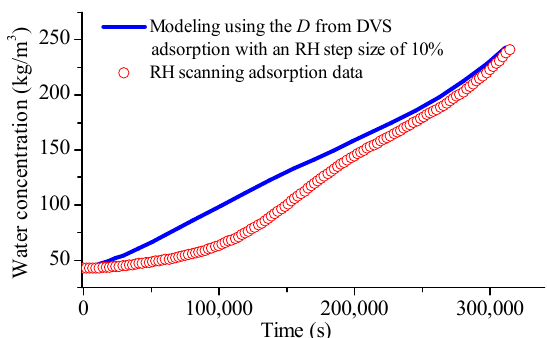
Figure 7. Evolution of water concentration of glutinous rice grains with time during the RH scanning DVS measurement and its prediction using the diffusivities from the DVS test with an RH step size of 10% according to Fick’s second law.